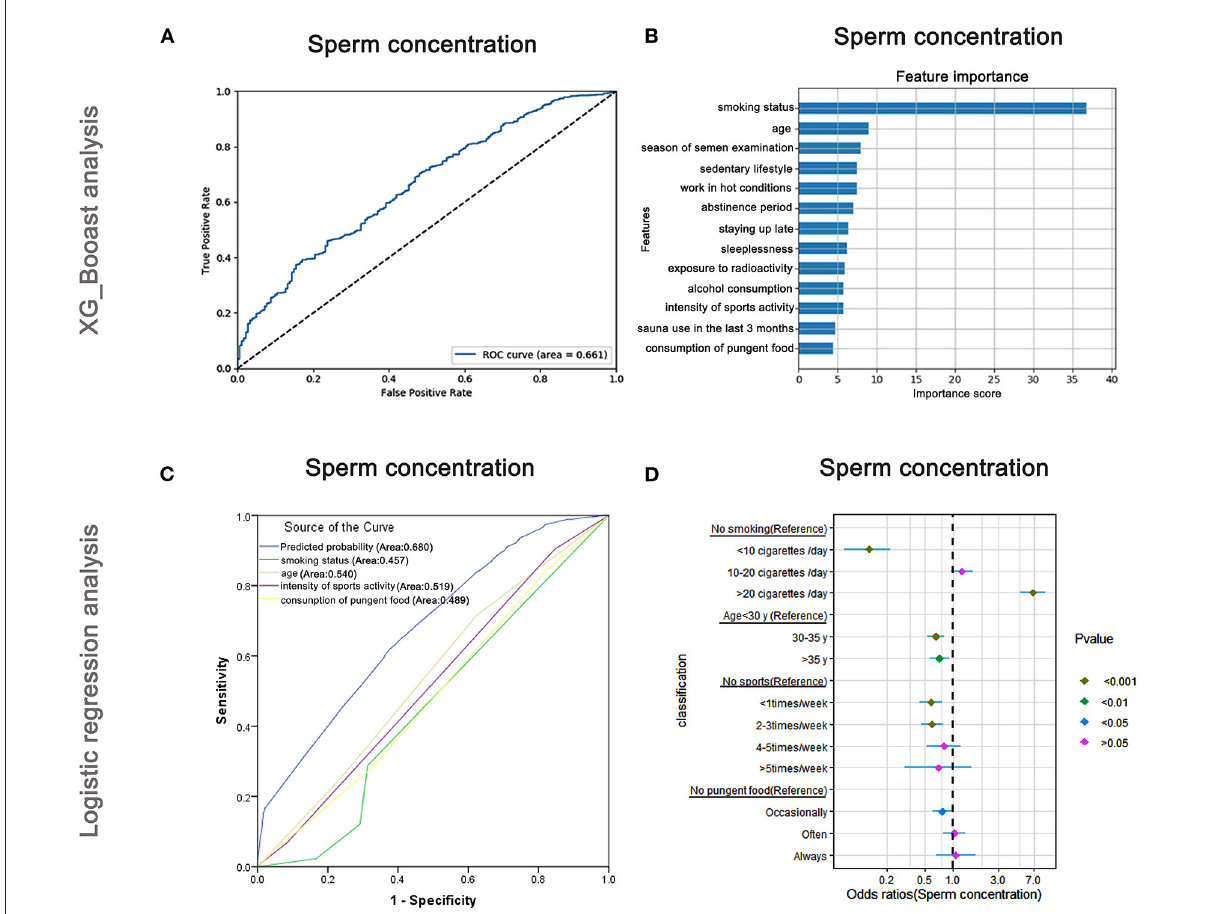
FIGURE4 XGBoost and logistic regression analysis of the risk factors for sperm concentration. The ROC curve (A) and feature importance (B) analyzed by XGBoost and the ROC curve (C) and forest diagram showing significant risk factors (D) analyzed by logistic